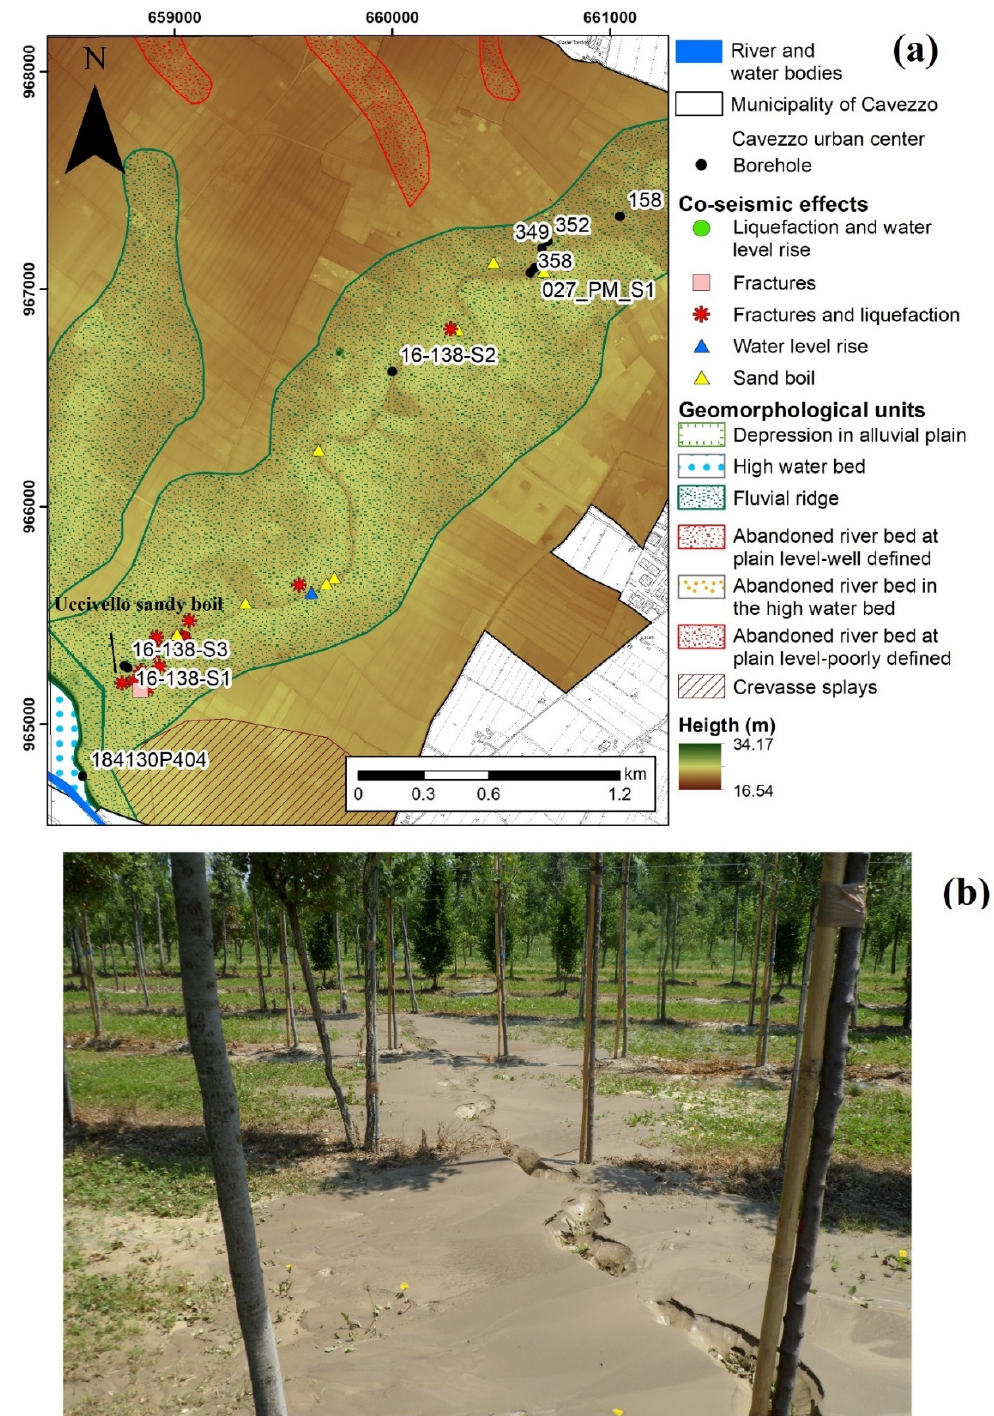
Figure 3. ( a ) Location of the boreholes sampled for classification tests; ( b ) Uccivello sand boil.